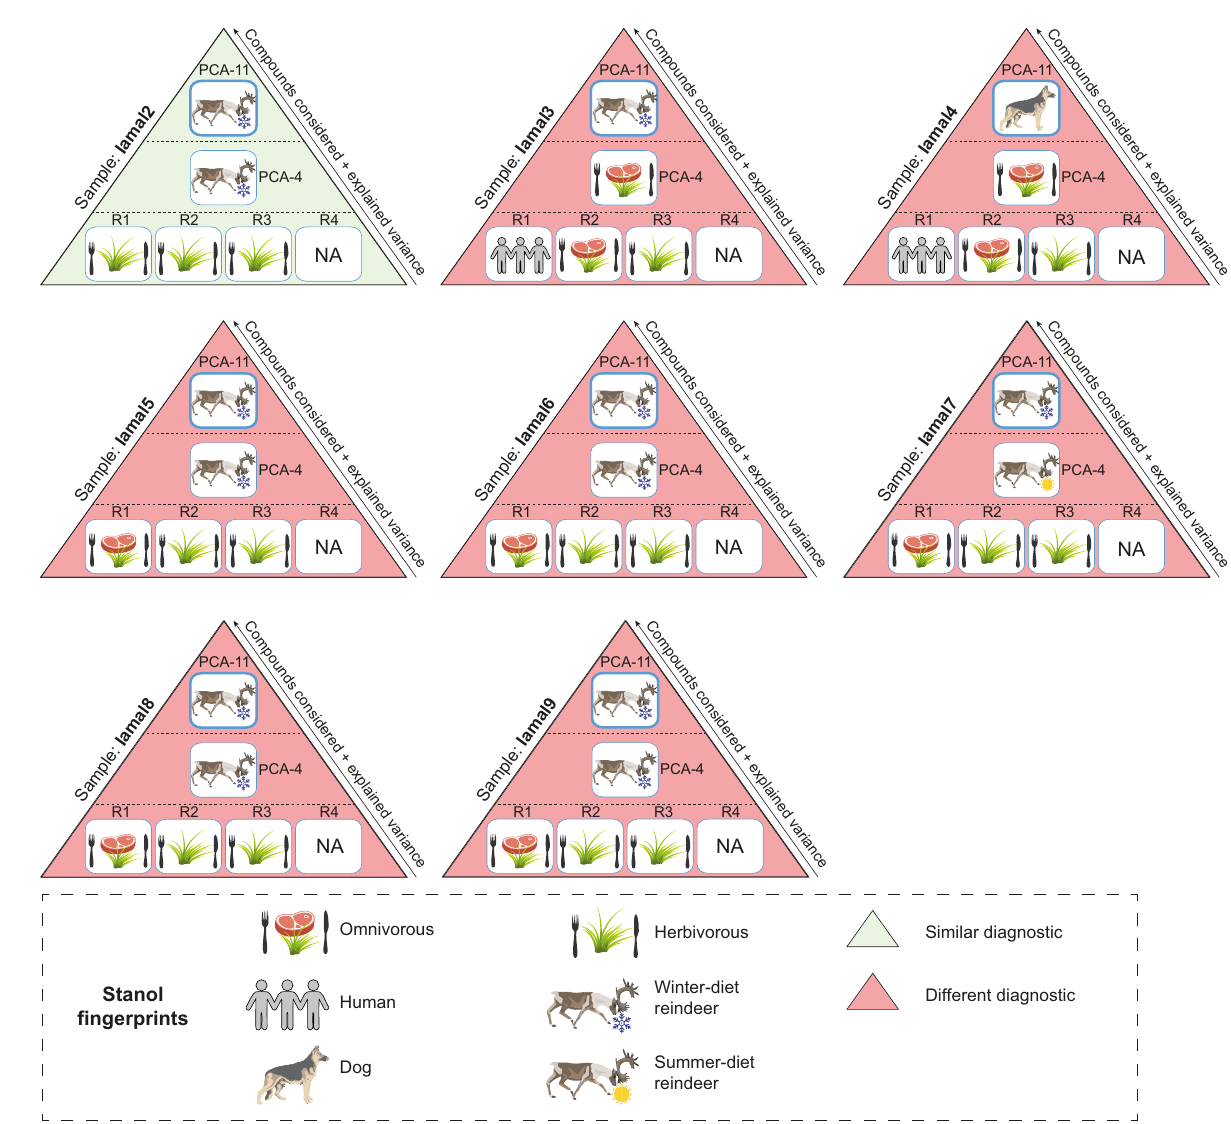
Fig 6. Summary comparison of diet and species identification using ratios and multivariate analyses for I ͡ Amal soil samples. More details are presented in S7 Table. R1 refers to the ratio of distributions of coprostanol/(coprostanol + 24-ethylcoprostanol) used to discriminate the herbivore fingerprint from human (herbivore = 0.38 < R1 < 0.73 = human, [20]). R2 refers to the ratio of distributions of (coprostanol + epicoprostanol)/ (24-ethylcoprostanol + 24-ethylepicoprostanol) used to identify the omnivore fingerprint (R2 > 1, [7]). R3 refers to the ratio of distributions of epicoprostanol/(cholestanol + coprostanol) used to discriminate the herbivore fingerprint from human (human = 0.01 < R3 < 0.1 = cattle and horse, [21]). R4, the diagnostic ratio for the horse fingerprint, is “not applicable” (NA) because no horses were present on this high Arctic site (see Text). PCA-4 refers to the predictive PCA and its corresponding HCPC built with the distribution of the four main 5 β -stanols (coprostanol, epicoprostanol, 24-ethylcoprostanol and 24-ethylepicoprostanol) in the human, dog, lemming and reindeer reference samples from our database. PCA-11 refers to the predictive PCA and its corresponding HCPC built with the distribution of eleven 5 β -stanols in the human, dog, lemming and reindeer reference samples from our database. Reindeer and horses are herbivores so diagnostics between ratios and multivariate analyses can be compared.